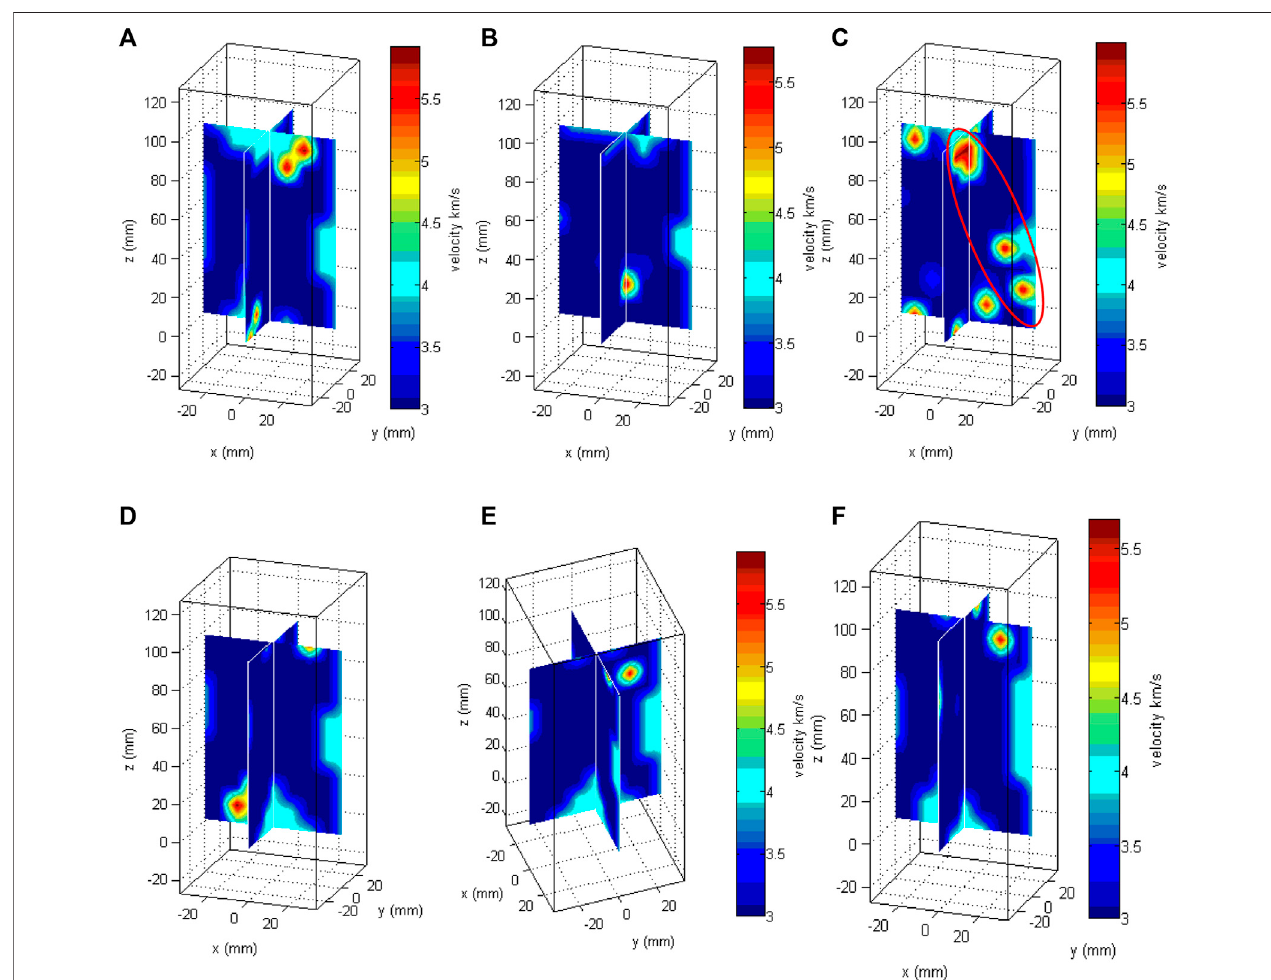
FIGURE 11| Velocity tomograms at (A) Stage I, (B) Stage II, (C) Stage III, (D) and (E) Stage IV (at two different view angles) and (f) Stage V of uniaxial compression test. The red circle in (C) indicates the distribution pattern of AE source locations.